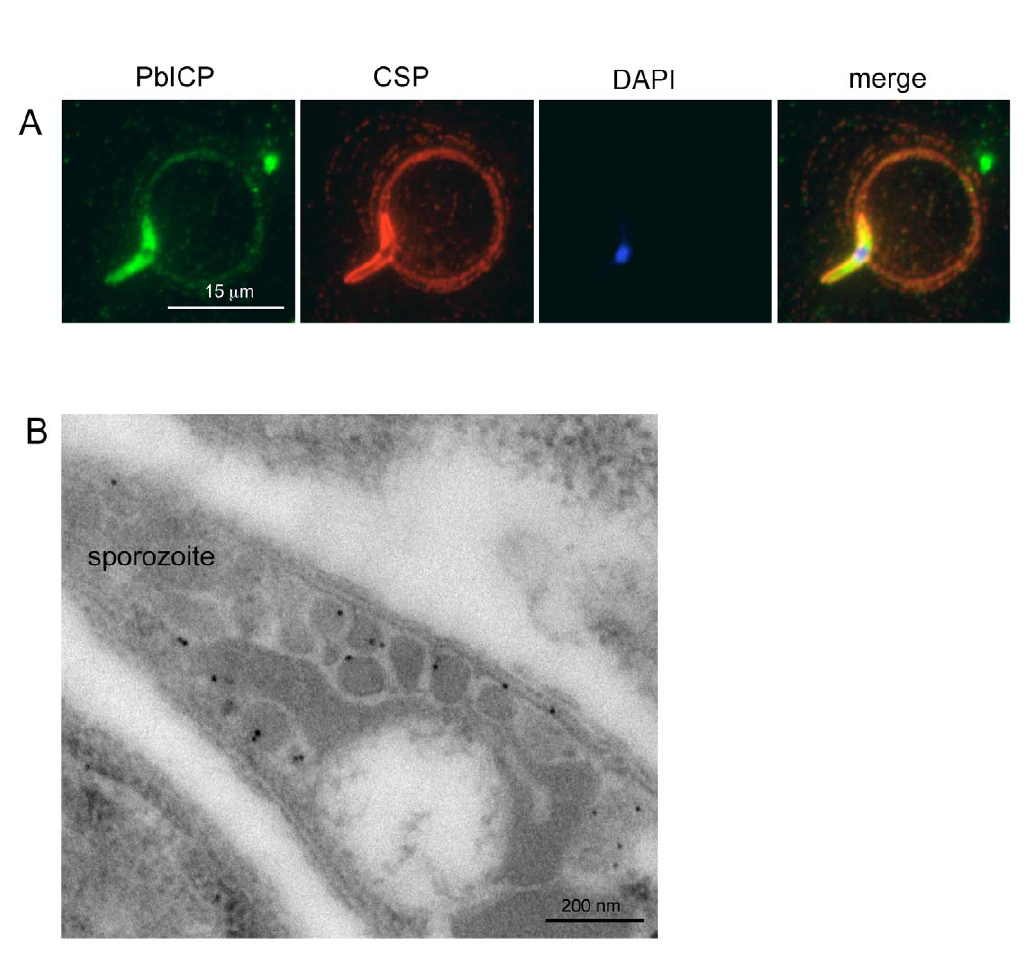
Figure 2. PbICP is secreted by salivary gland sporozoites. ( A ) Widefield IFA of P. berghei sporozoites that have been allowed to glide on glass coverslips. Sporozoites were fixed after 1 h and subsequently stained with anti-CSP antiserum (mouse, red) and polyclonal antiserum against PbICP-C (rabbit, green). DNA was stained with DAPI (blue). Like the shedded surface protein CSP, PbICP was detected in a patchy pattern in the trails of the circling sporozoites. ( B ) IEM confirms PbICP localization in vesicles of a midgut sporozoite. P. berghei infected A. stephensi midguts were fixed 20 days after infection and prepared for IEM. Ultrathin sections were stained with polyclonal antiserum directed against PbICP-C (rabbit) and subsequently with gold-labeled Protein A (10 nm gold particles). The sections were contrasted with uranyl acetate and lead citrate.